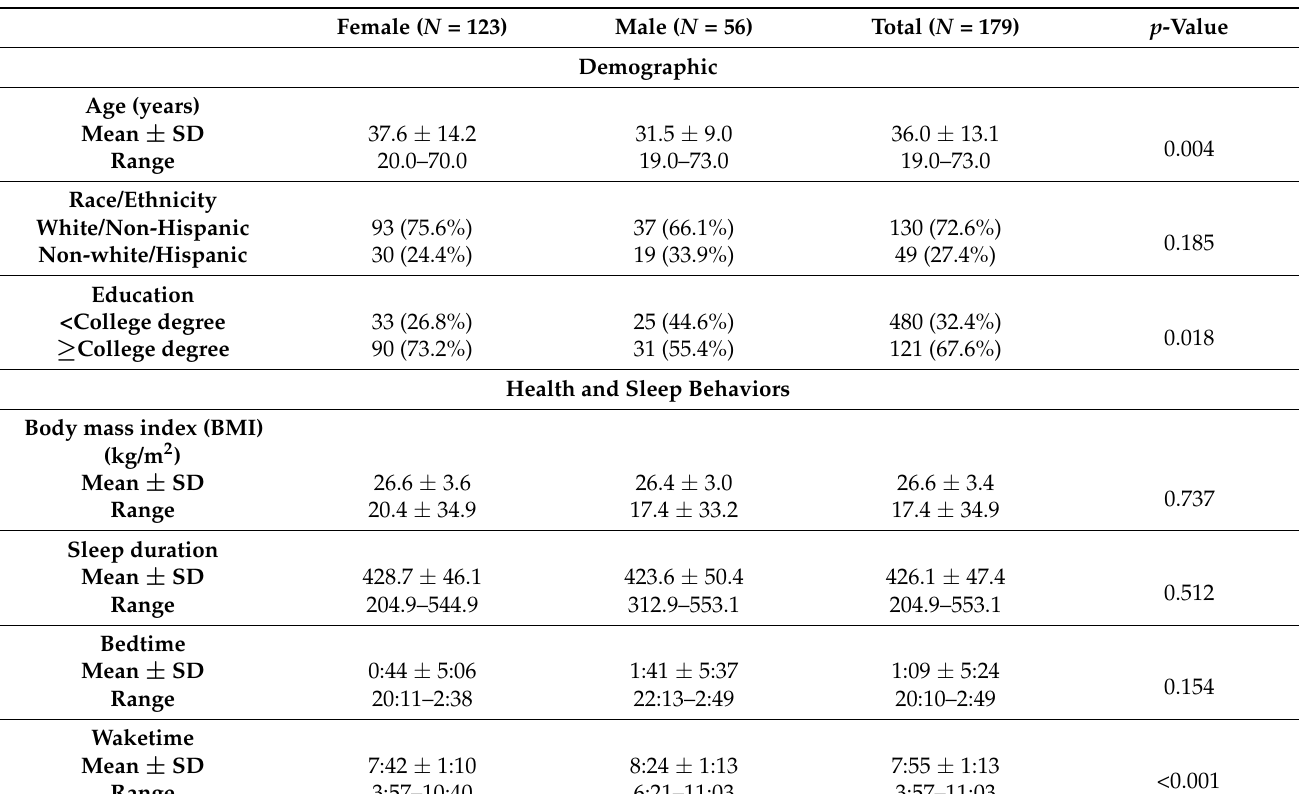
Table 1. Baseline descriptive characteristics of the overall analytic sample and by